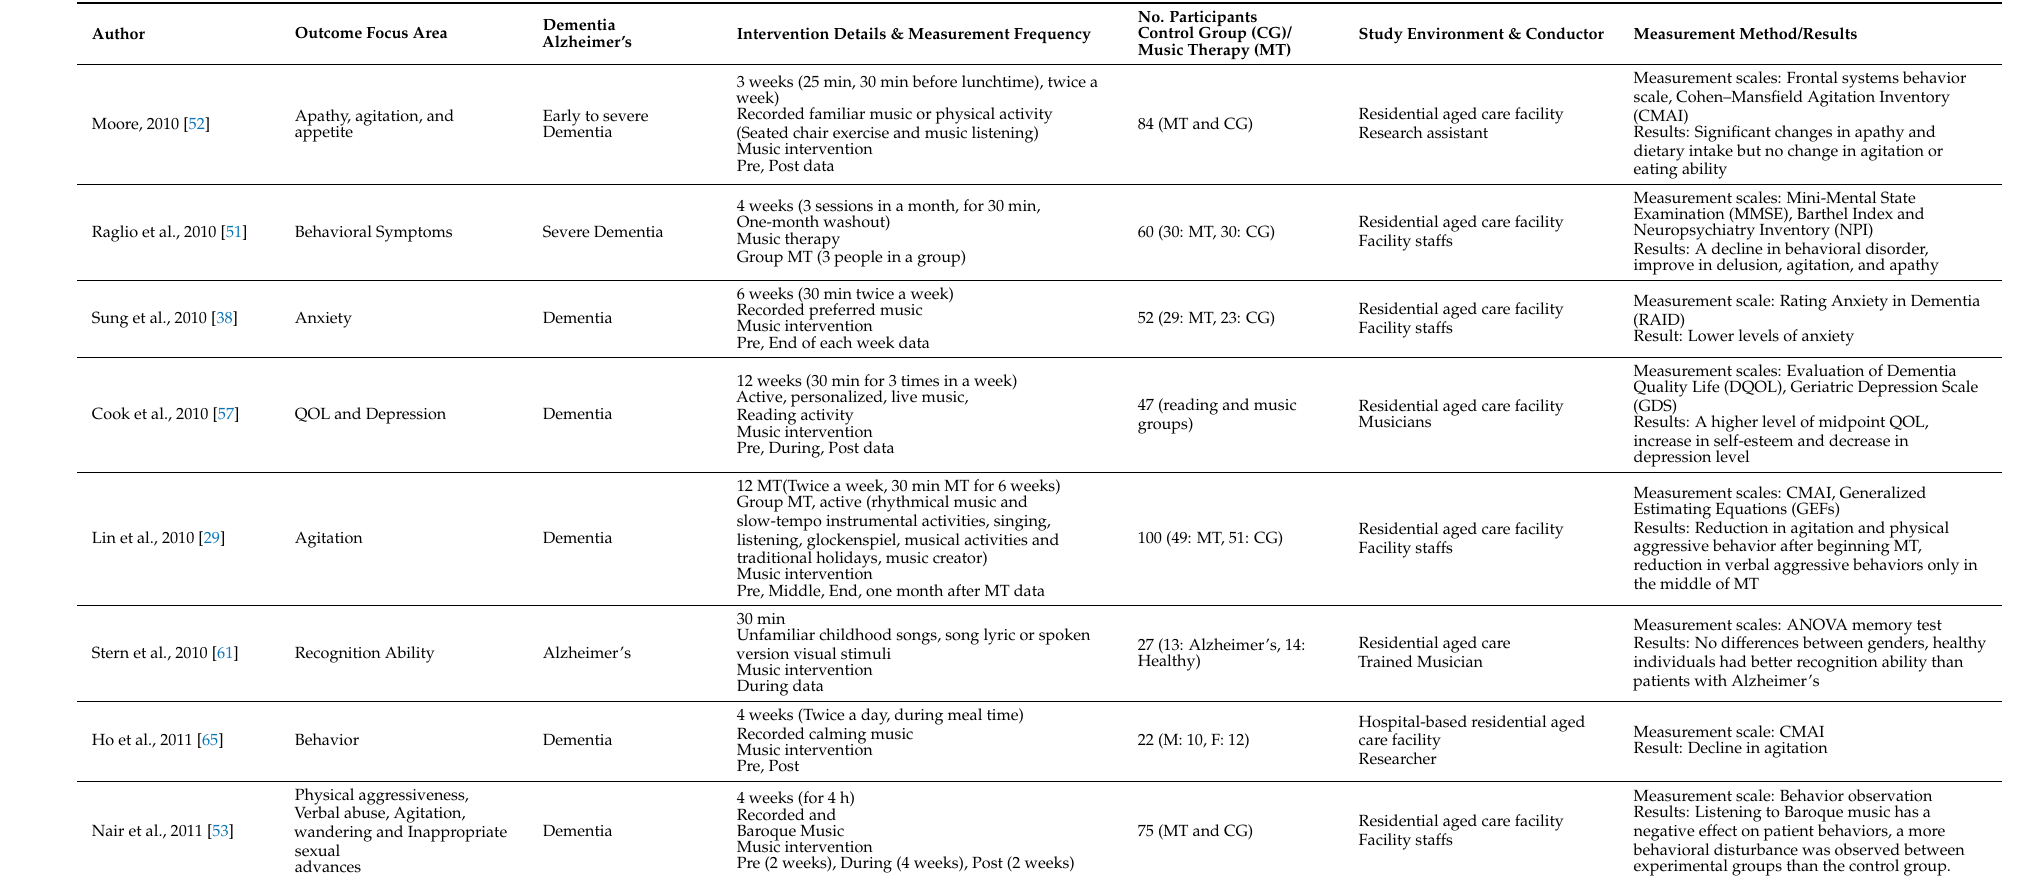
Table A1. Summary of studies on music intervention for dementia-related